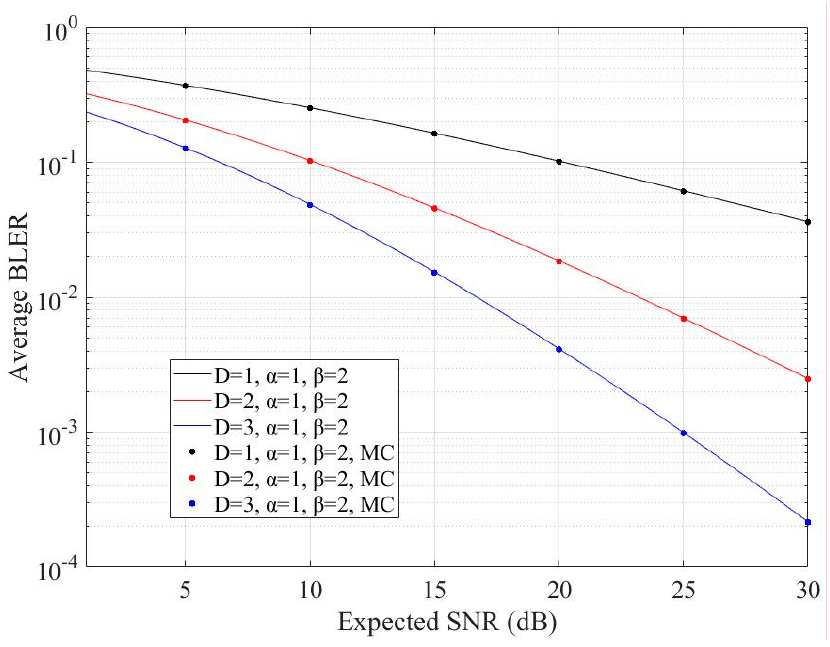
Figure 5. ABLER performance versus the expected SNR for M = 1, N = 4, negligible pointing errors impact, and 4-PPM scheme, accompanied by the corresponding Monte Carlo simulations.